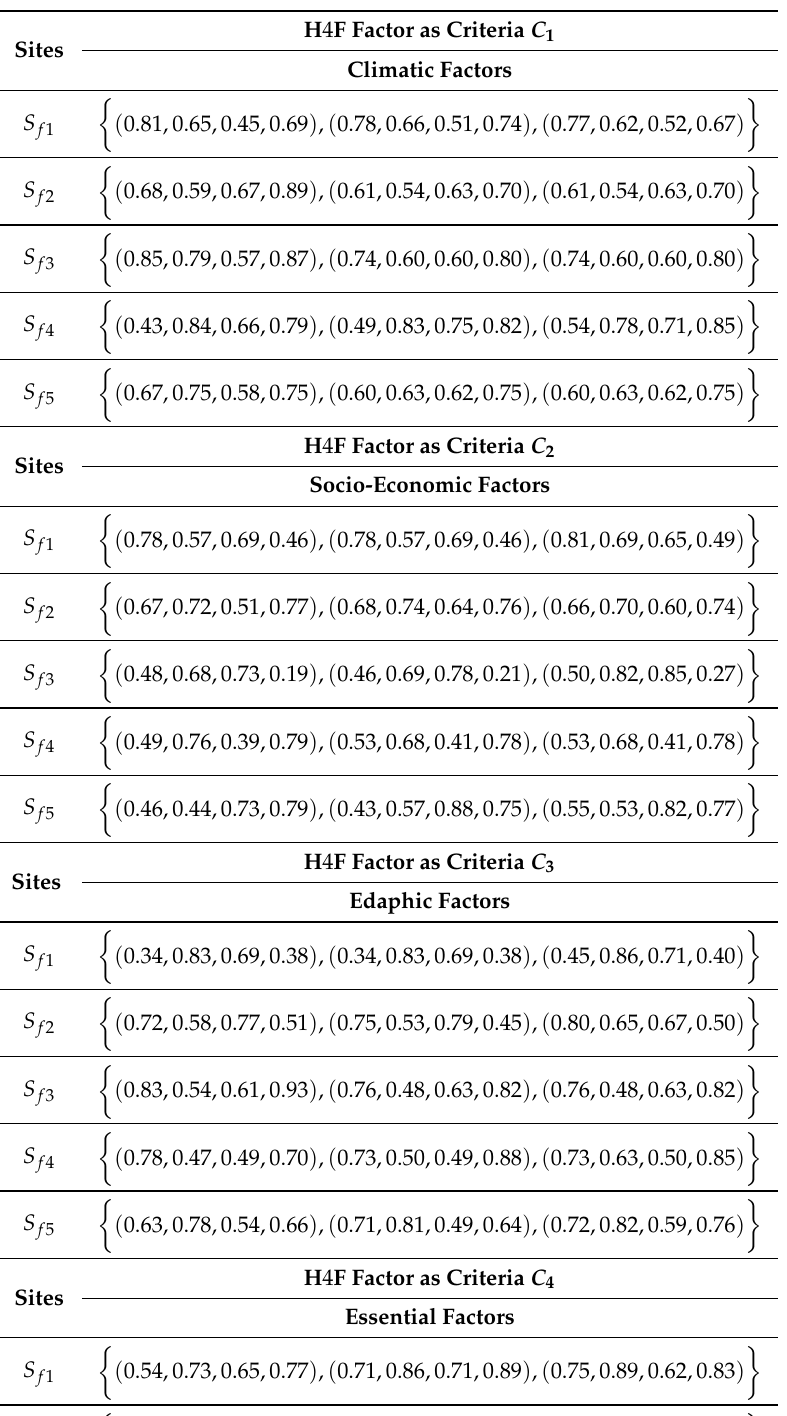
Table 10. Tabular representation of pessimistic H4F decision